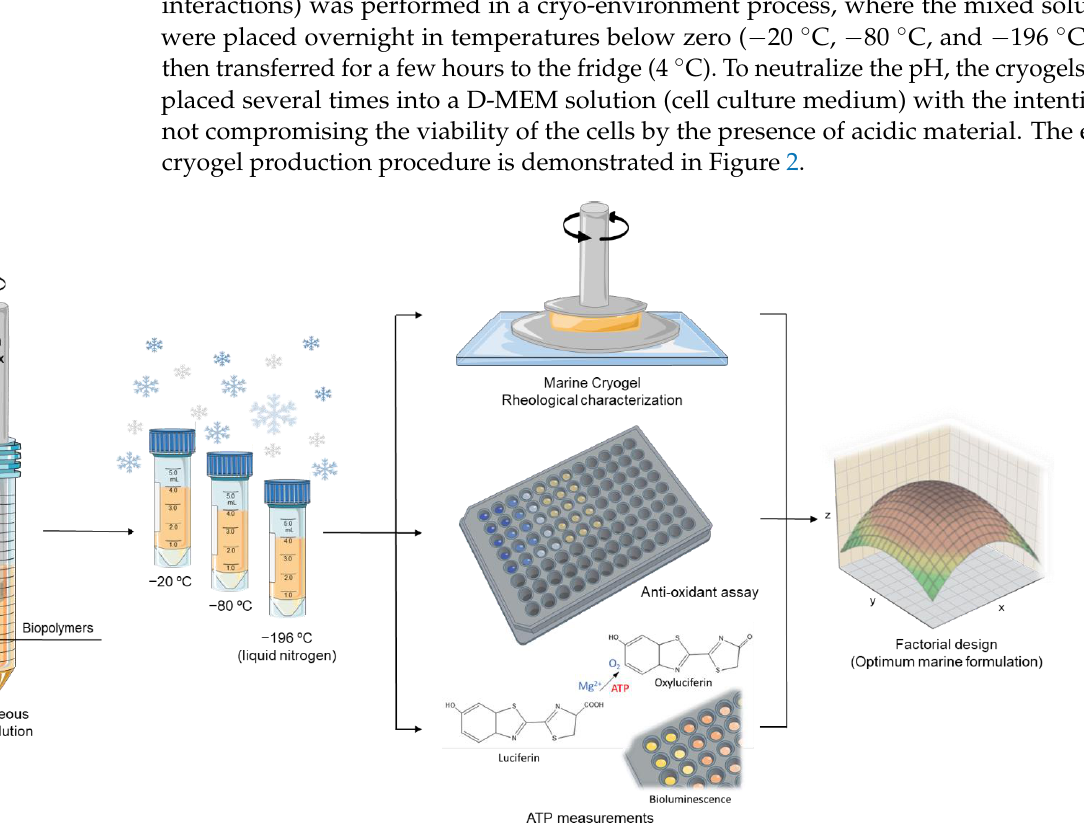
Figure 2. Schematic representation of the marine cryogel formation procedure comprising homogenization and freezing at different temperatures and then its characterization, aiming for a factorial design to extrapolate the optimum marine cryogel formulation according to the obtained results from rheology, anti-oxidants activity, and ATP measurements.